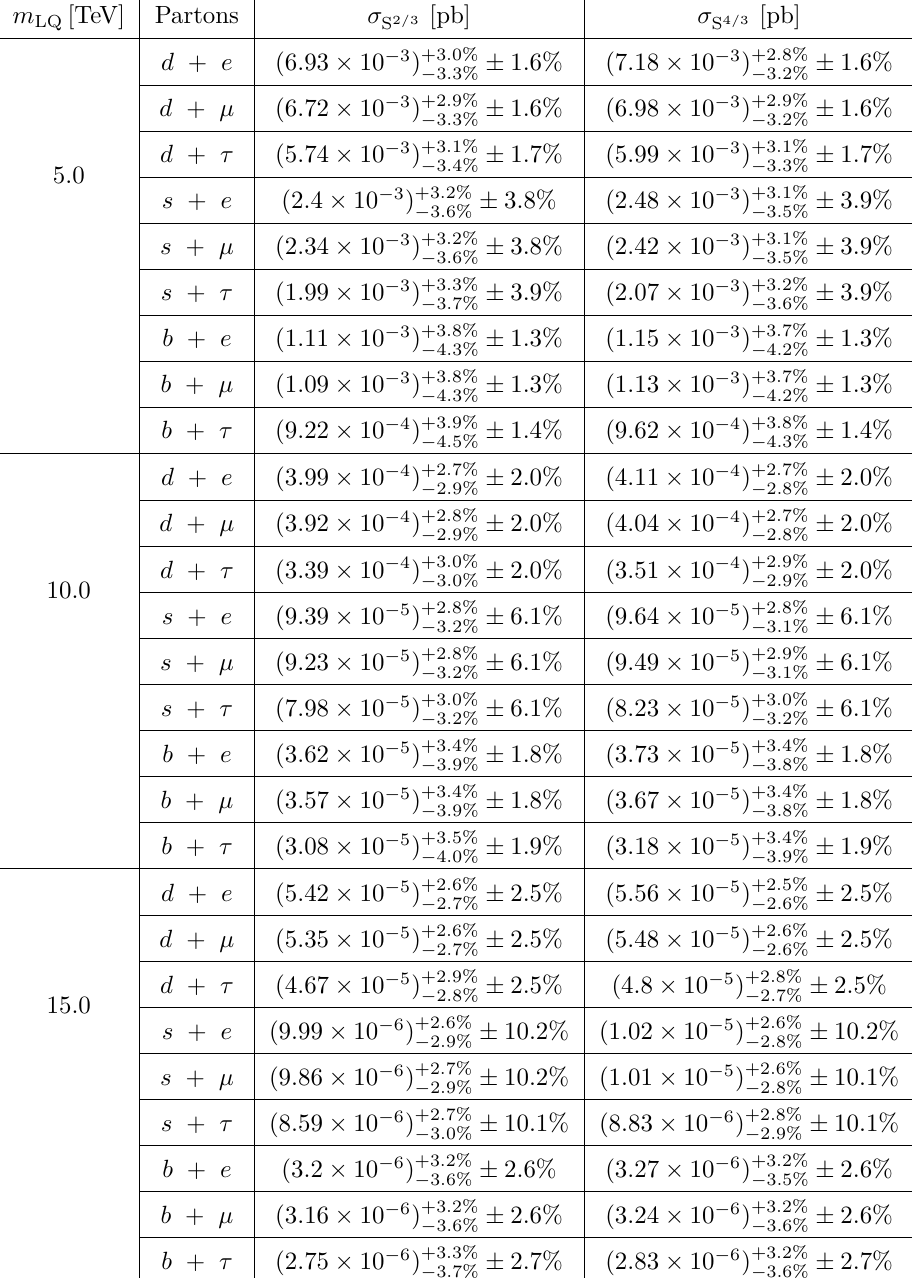
Table 2 . Inclusive cross sections (in pb) at NLO for the resonant leptoquark production pp → LQ √ plus pp → LQ at s = 100 TeV from down-type quarks and charged leptons. For each flavour combination q‘ reported in the second column, the associated Yukawa coupling in eq. (2.1) is = 1 while y R = 0 . The last two columns are for scalar leptoquarks with electric charges ± 2 / 3 y L q‘ q‘ and ± 4 / 3 , respectively. The two displayed uncertainties are due to the scale variations (first) and PDF replicas (second). See section 3.1 for